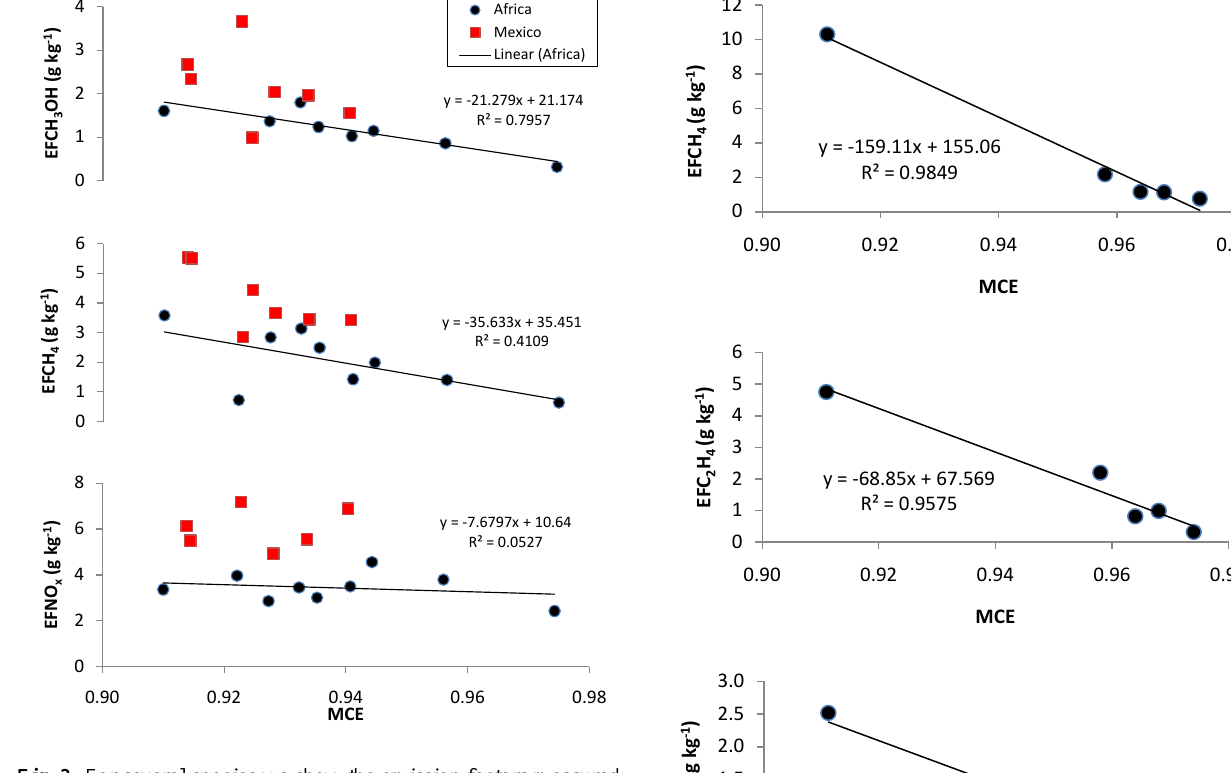
Fig. 3. For several species we show the emission factors measured during the late dry season on savanna fires in Africa (and a fit) for comparison to the emission factors measured on early dry season savanna fires in Mexico. The emission factors for the early dry season fires are higher and lie above the fit for African late season fires for most species as discussed in the text.